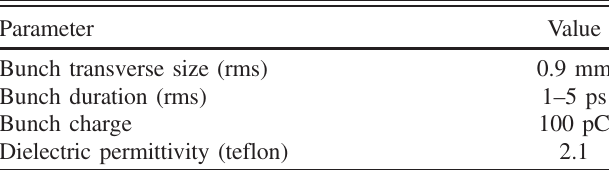
TABLE I. Simulation parameters.